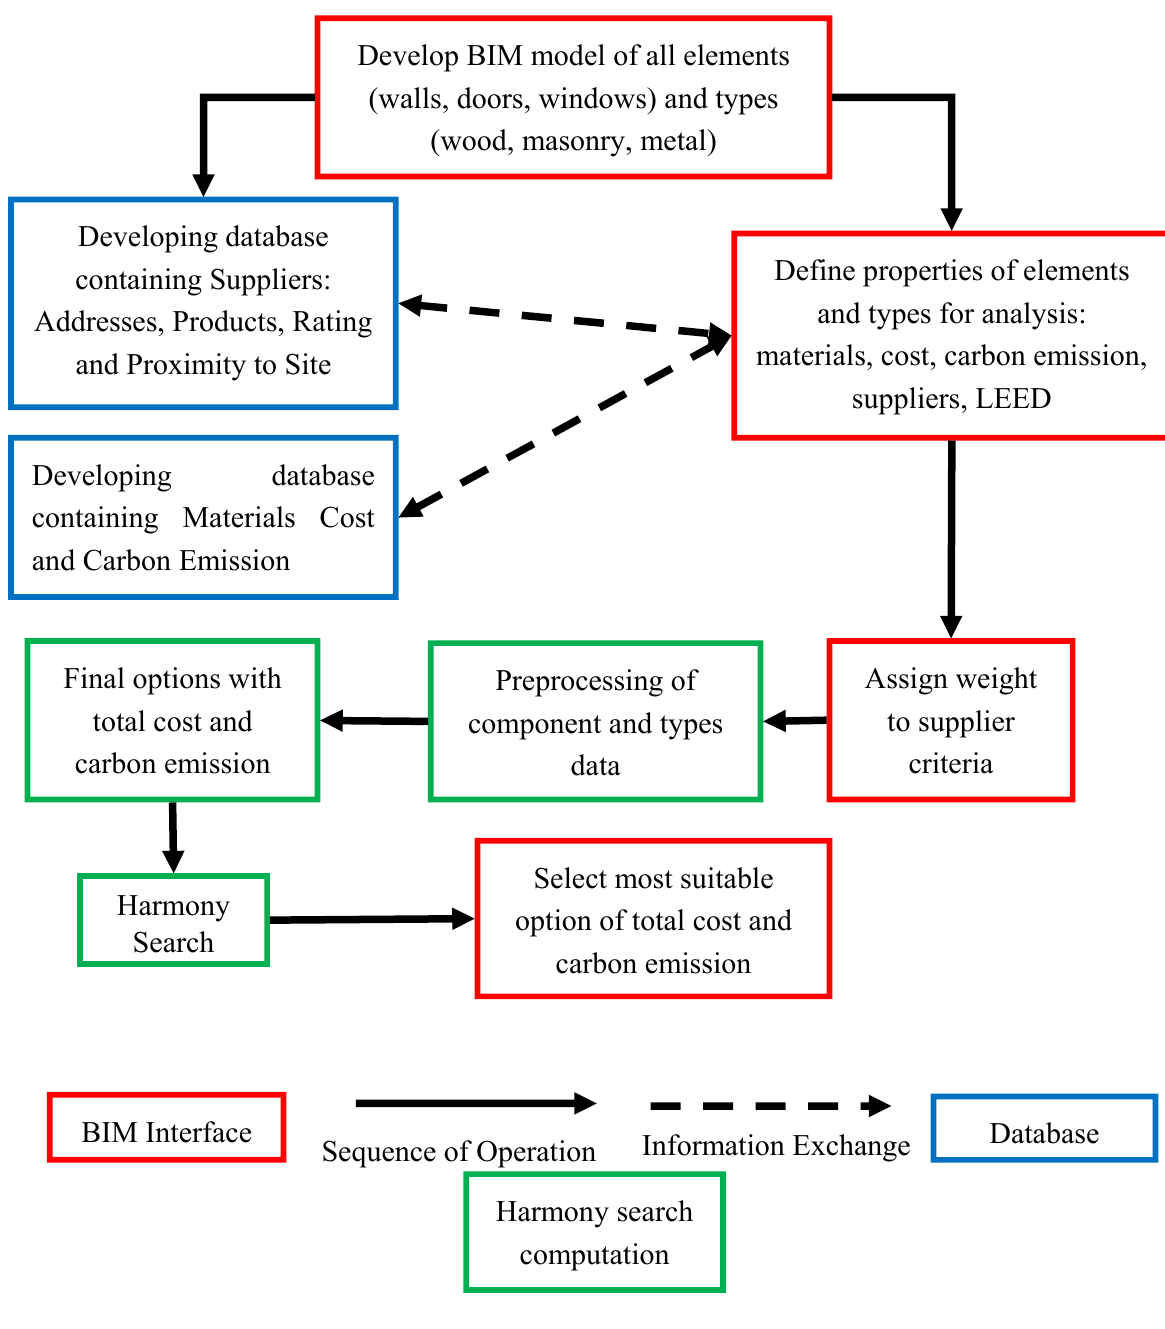
Figure 2. Information flow in decision support